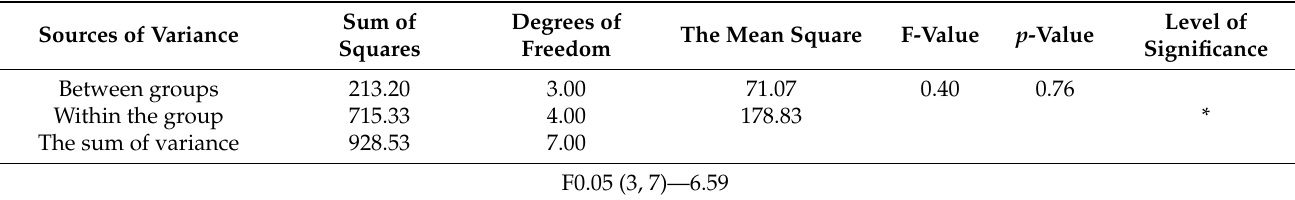
Table 8. Analysis of 28 − day compressive strength variance of